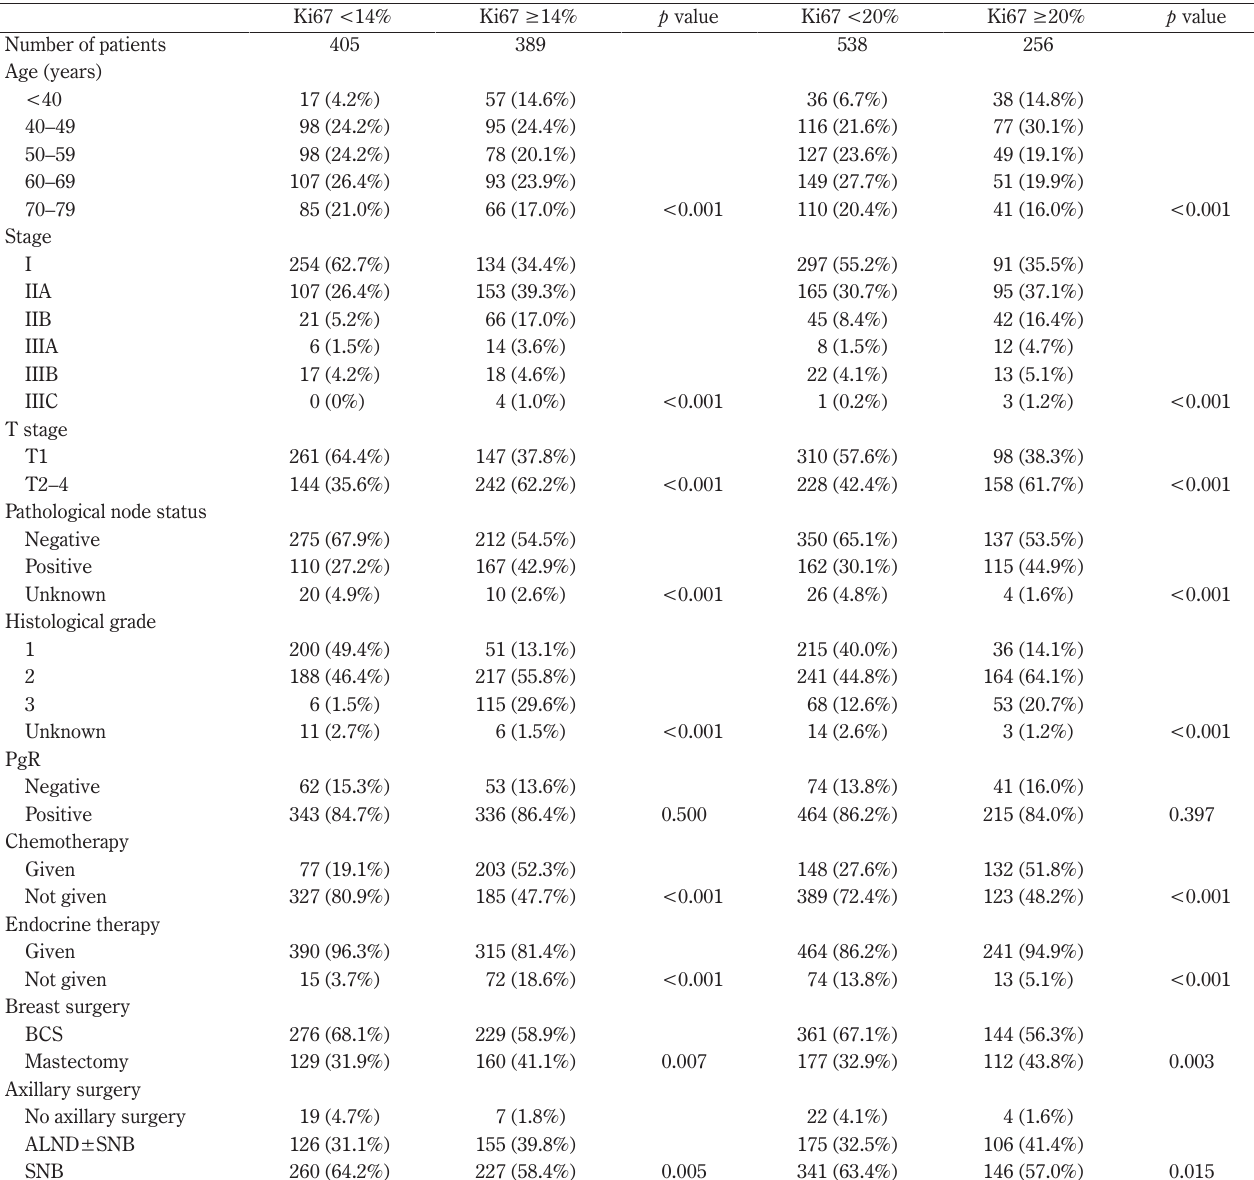
Table 1 Clinical profile of patients with ER+/HER2– breast cancer according to two Ki67 cutoffs